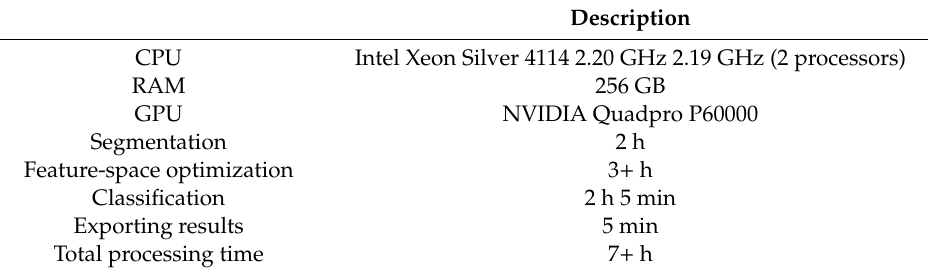
Table A3. Hardware and processing time for image processing conducted in eCognition.